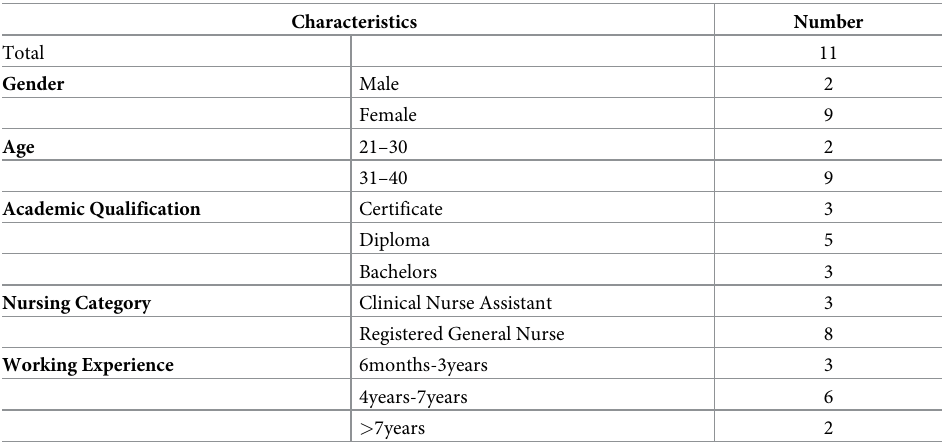
Table 1. Participants